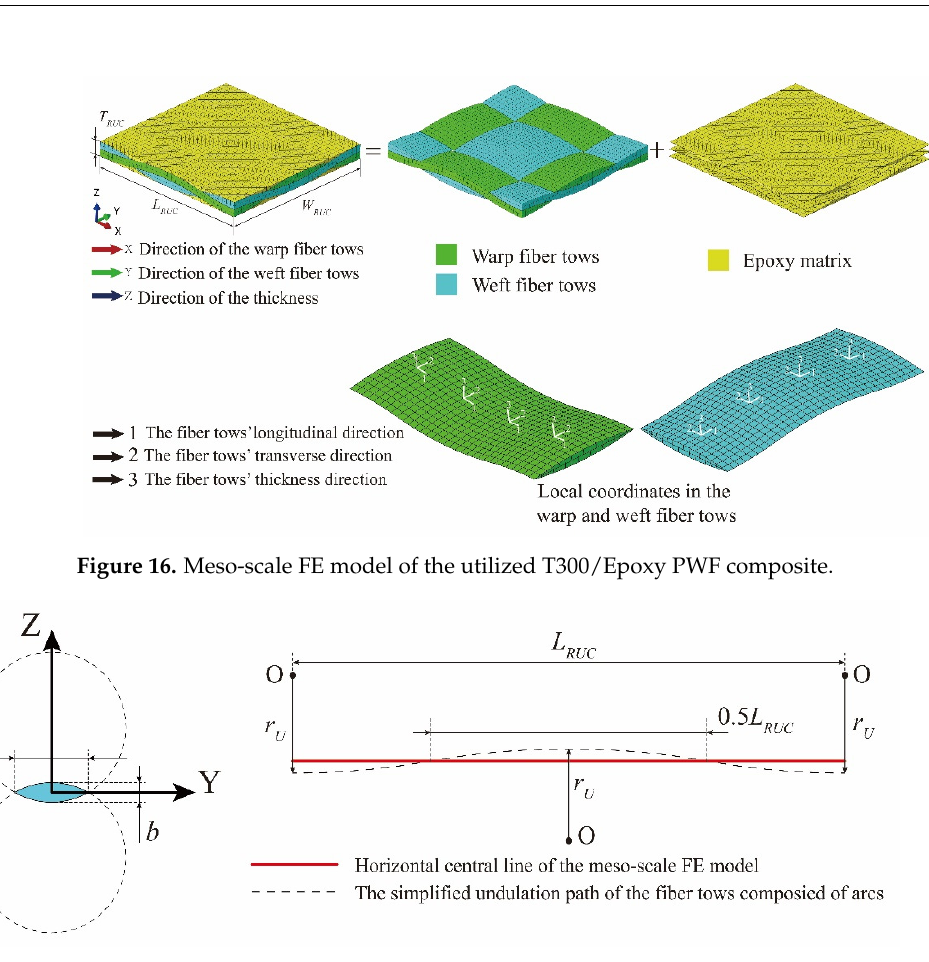
Figure 17. The simplification of the cross-section and undulation path for the fiber tows in the meso-scale FE model. Table 6. The geometric parameters of the meso-scale FE model for the T300/Epoxy PWF composite. Geometric Parameter